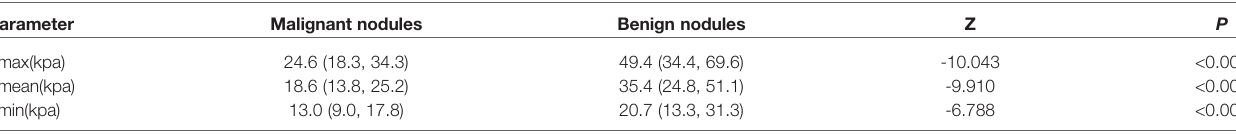
TABLE 1 | Comparison of the SWE quantitative parameters between the benign and malignant thyroid nodules.